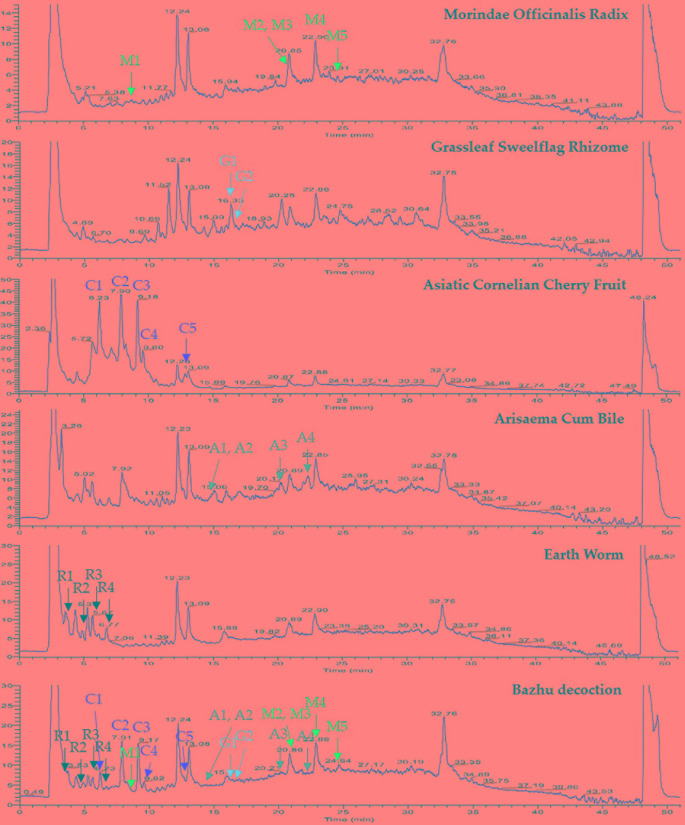
UHPLC-MS chemical fingerprint of BZD. Asperuloside (M1), rubiadin (M2), physcion (M3), rubiadin-1-methyl ether (M4), 1,6-dihydroxy-2-methoxyanthraquinone (M5), 2,4,5-trimethoxybenzaldehyde (G1), β-asarone (G2), 5-hydroxymethyl-2-furaldehyde (C1), morroniside (C2), loganin (C3), sweroside (C4), cornuside (C5), taurochenodeoxycholic acid (A1), glycohyodeoxycholic acid (A2), cholic acid (A3), hyodeoxycholic acid (A4), leucine (R1), adenine (R2), phenylalanine (R3), and tryptophan (R4).